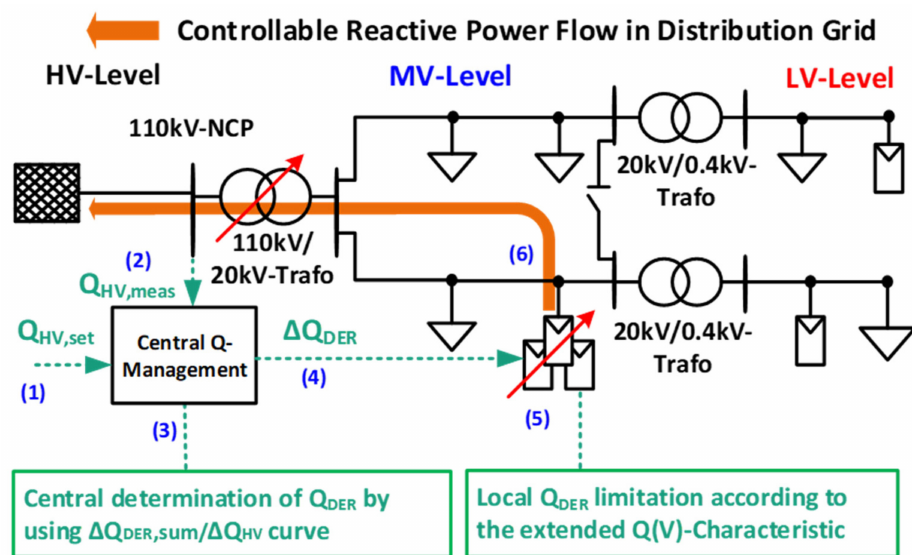
Figure 1. The proposed application-oriented reactive power management concept.